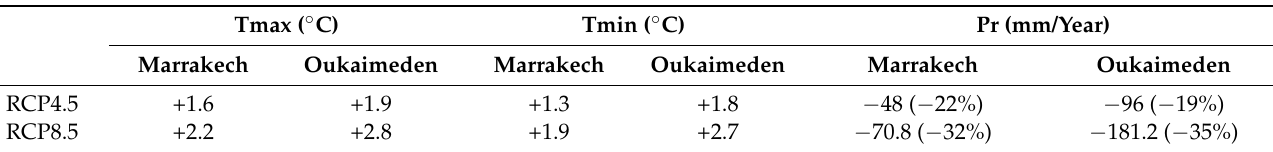
Table 4. Annual change in temperature (Tmax, Tmin) and precipitation medians by the model ensembles on the stations of Marrakech and Oukaimeden_CAF over 2050.